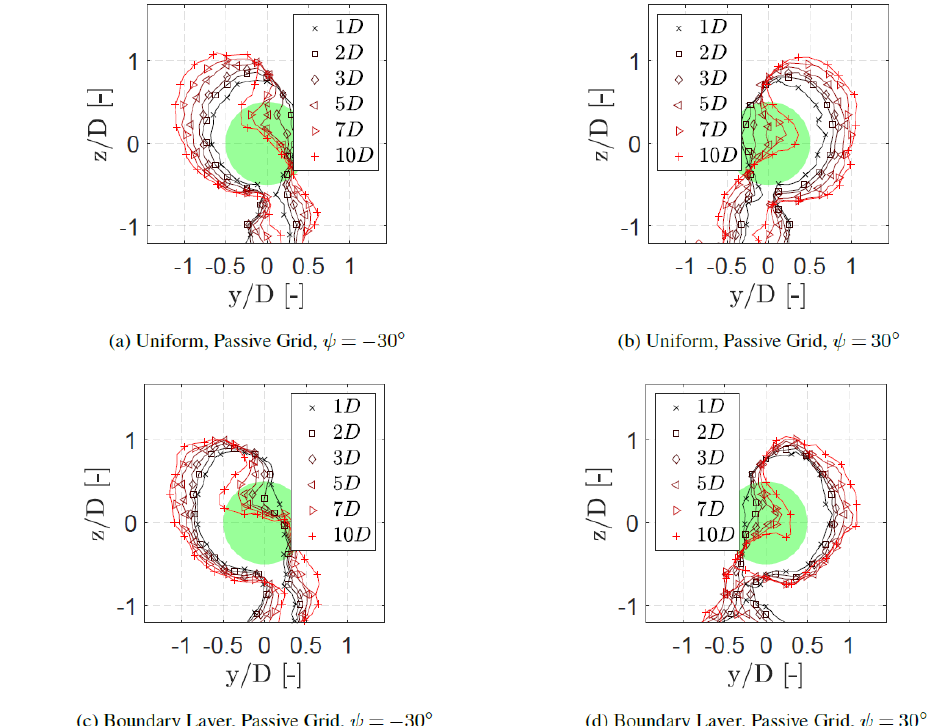
Figure 9. Growth of the curled wake behind the wind turbine model at multiple downstream distances. The contour lines indicate the − u i = 0 . 9 at each downstream location. The view is looking upstream towards the turbine model. boundary with u i , ∞ u i , ∞